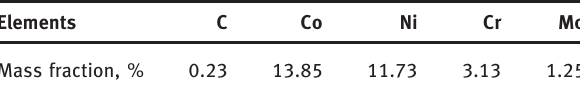
between the anvil and the specimen interface. Isothermal compression was conducted in a Gleeble 1500 thermal simulator at constant strain rates of 0.001, 0.01, 0.1, 1.0, and 3.0 s − 1 and at experimental temperatures of 900 – 1,200°C with 50°C intervals. Before the hot compression, the specimens were heated to 1,200°C at a speed of 20°C/ s, with heat preservation for 5 min, and cooled to the deformation temperature of 10°C/s, with heat preserva- tion for 10 min. The specimens were water-quenched after deformation to maintain the deformed microstructure.